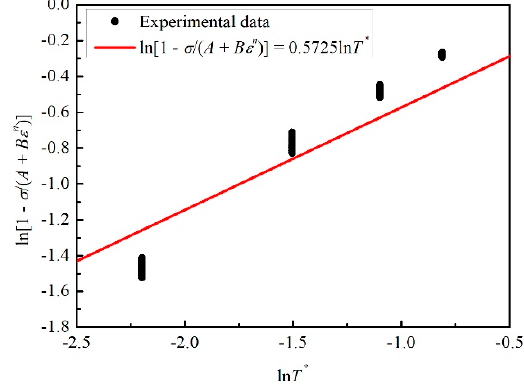
Figure 5. The relation between ln(1 − σ /( A + B ε n )) and ln T *.